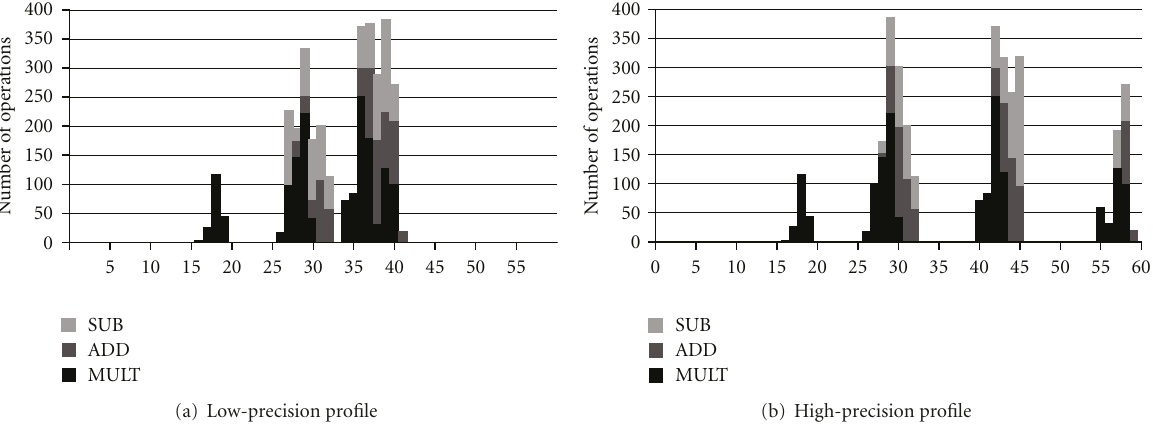
Figure 6: Operation’s word-length requirements for the JPEG decompression description.